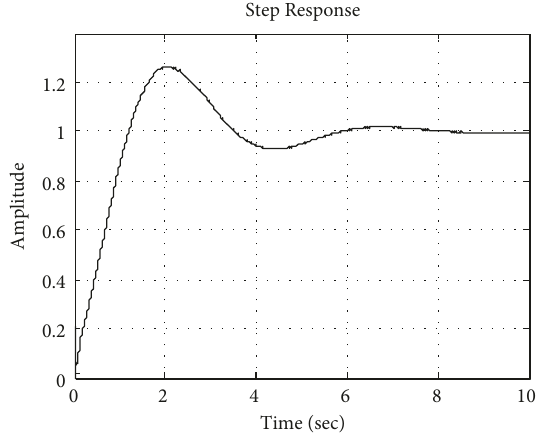
Figure 29: Response curve at 10 times β